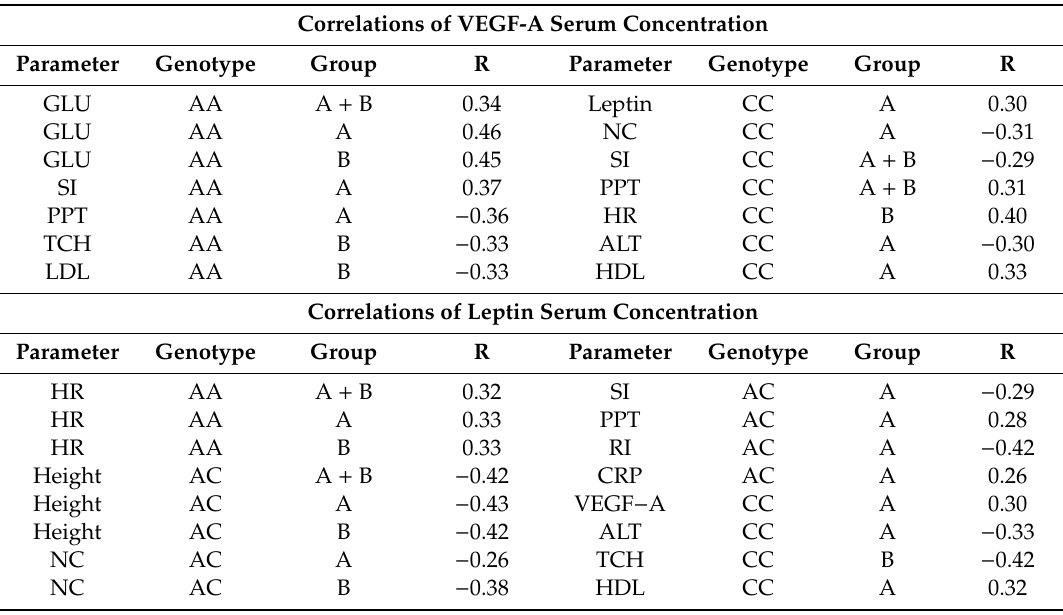
Table 9. Significant correlations of VEGF-A and leptin serum concentrations for rs699947 ( − 2578 C / A) variant of VEGF gene. Group A-study group. Group B-control